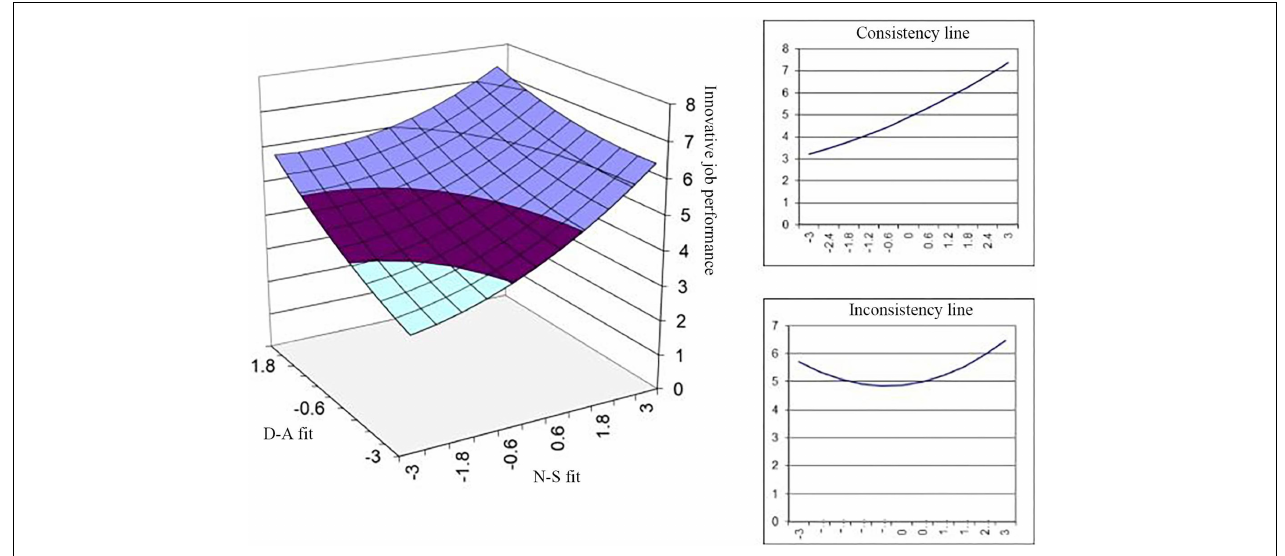
FIGURE 3 | Effects of P-E fit on innovation performance. TABLE 4 | Test results of job satisfaction’s mediating